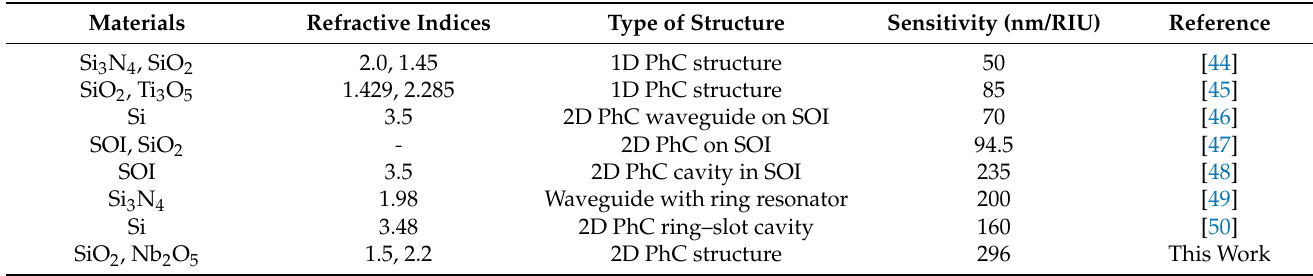
Table 3. Comparative analysis of presented and previously reported works on RI sensors and their